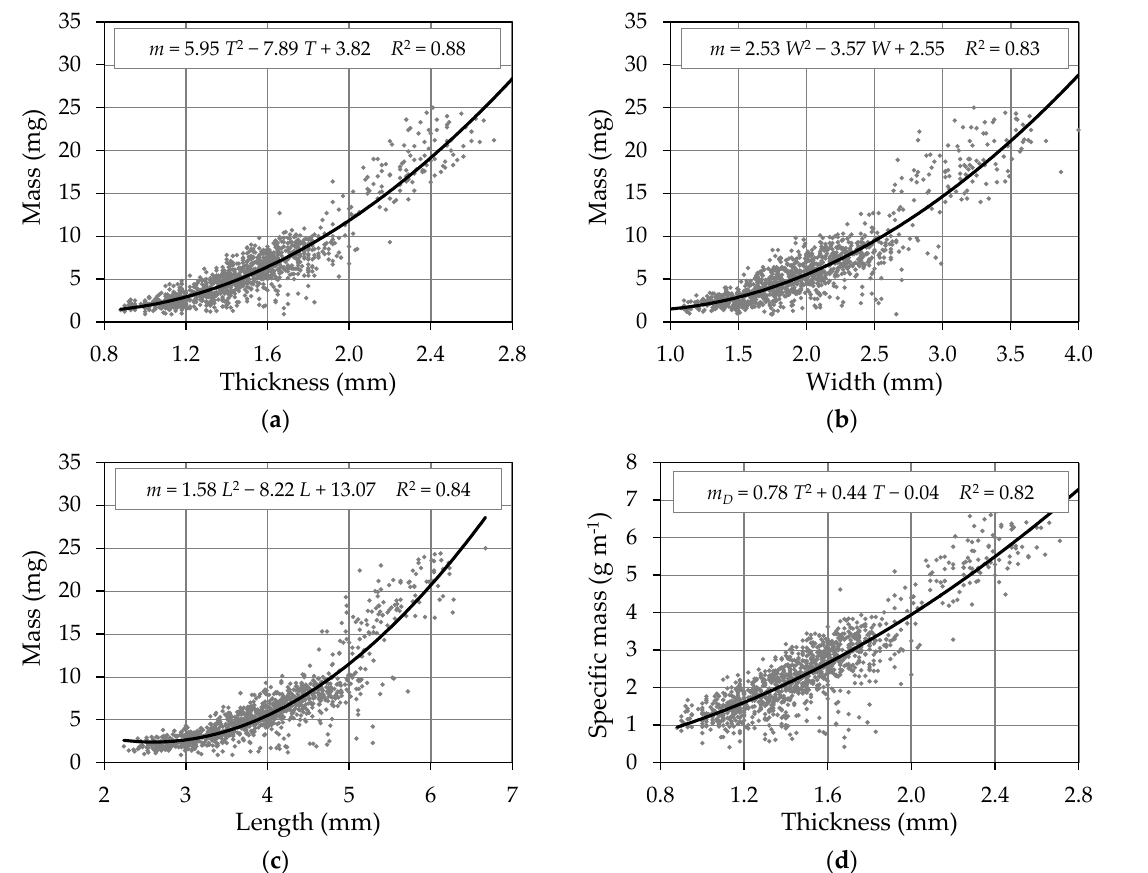
Figure 2. Relationships between the physical properties of spruce seeds: ( a ) thickness and mass; ( b ) width and mass; ( c ) length and mass; ( d ) thickness and specific mass.